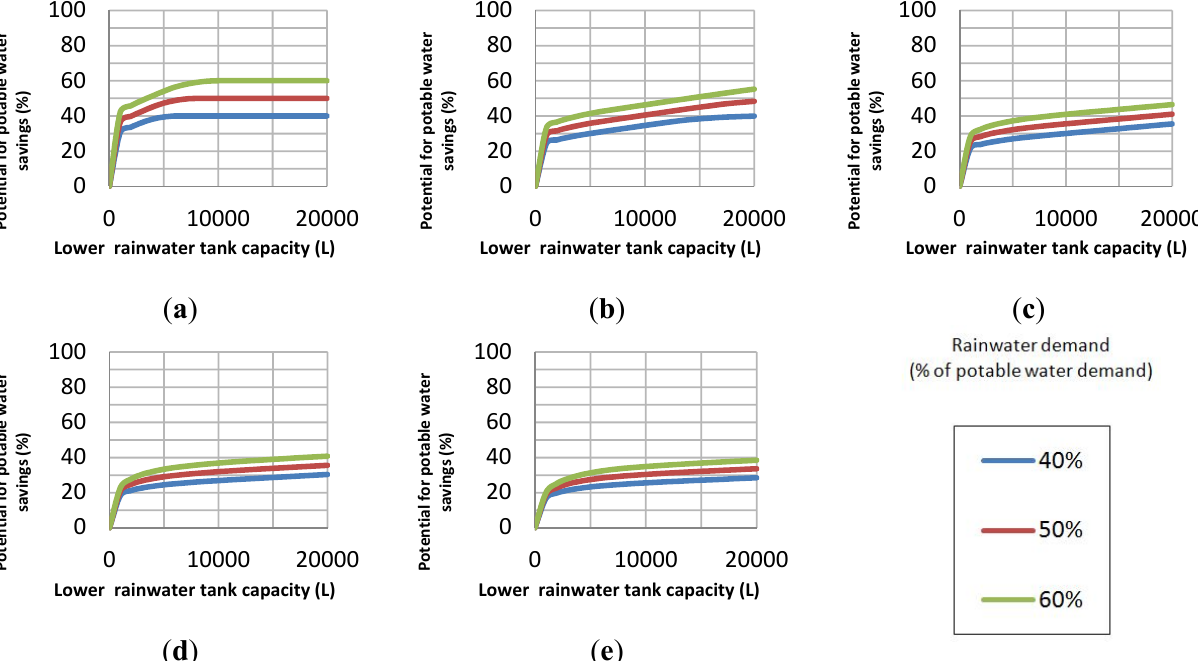
Figure 13. Potential for potable water savings as a function of lower rainwater tank capacity and potable water demand for Darwin, Australia, for a catchment area of 400 m 2 and different potable water demands. ( a ) 100 L per house per day; ( b ) 300 L per house